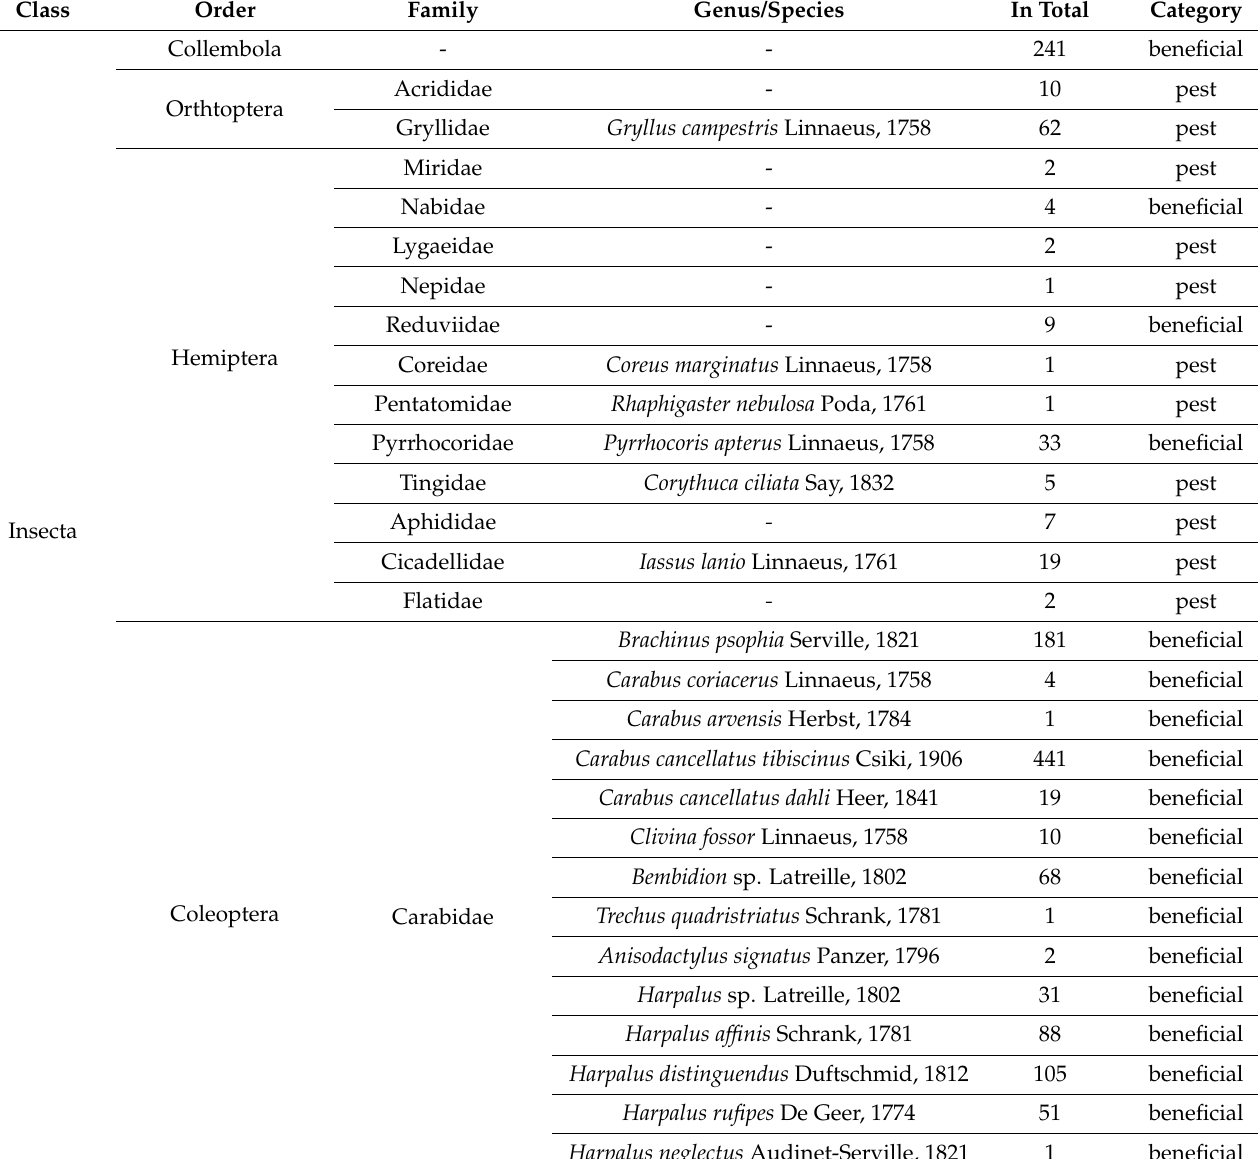
Table 2. The number and composition of the soybean soil-dwelling